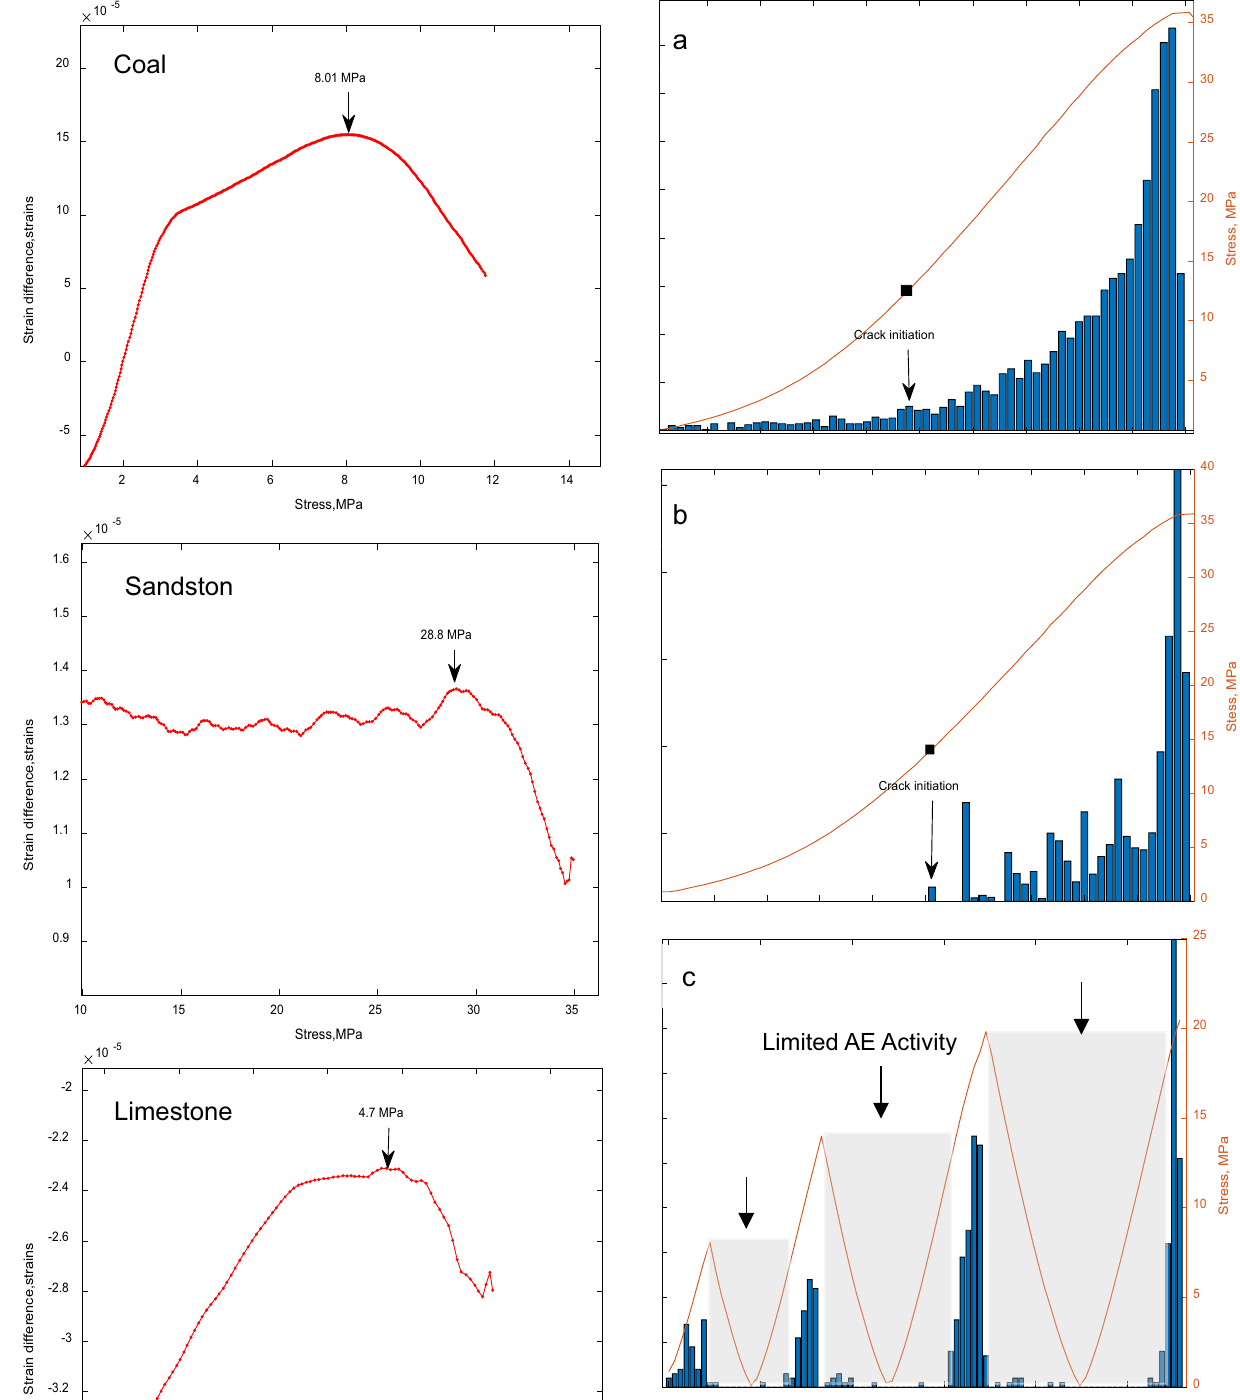
Fig.11 a , b AE activity during UCS test of sandstone specimen; c Cyclic loading of coal specimen showing limited AE activity in the subsequent cycles until the applied load is